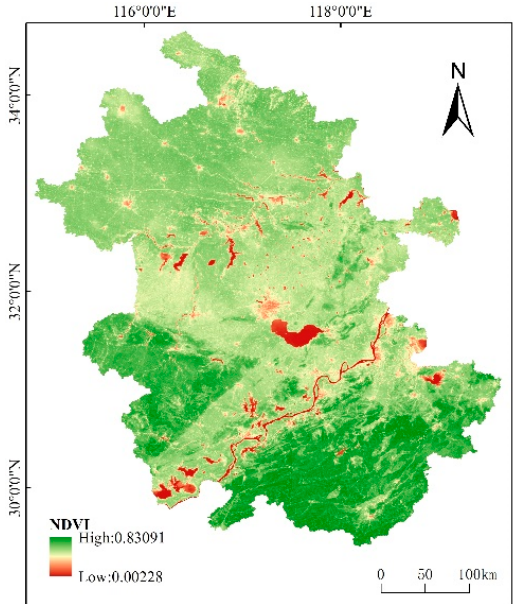
Figure 4. Interannual spatial distribution of NDVI in Anhui Province from 2001 to 2019. NDVI values ranged from 0.00228 to 0.83091.